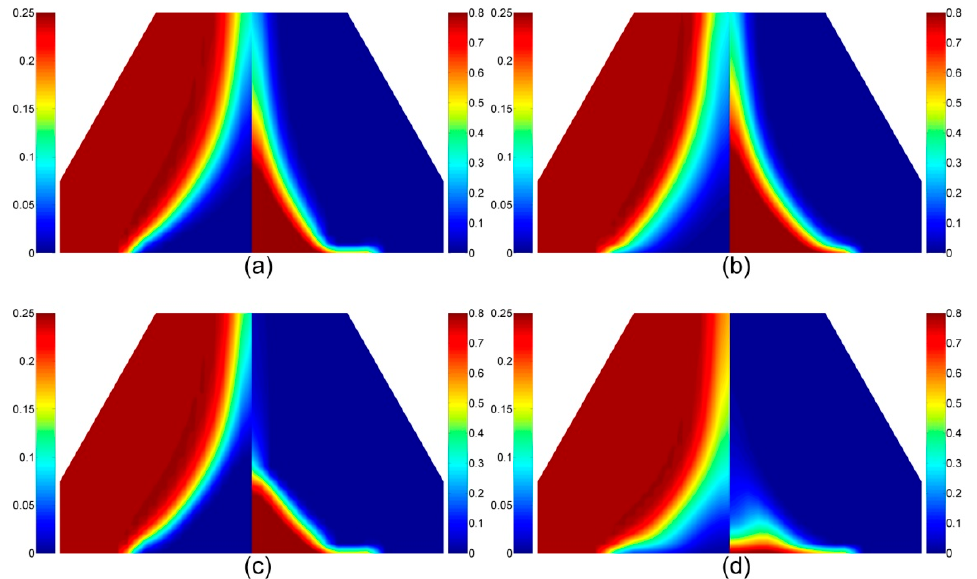
Figure 10. The mass fractions of O 2 (left hand side) and fuel (right hand side) in the gas phase for a 10 mm thickness PC plaque under 75 kW/m 2 heat flux at: ( a ) 100 s; ( b ) 400 s; ( c ) 800 s; and ( d ) 1100 s.